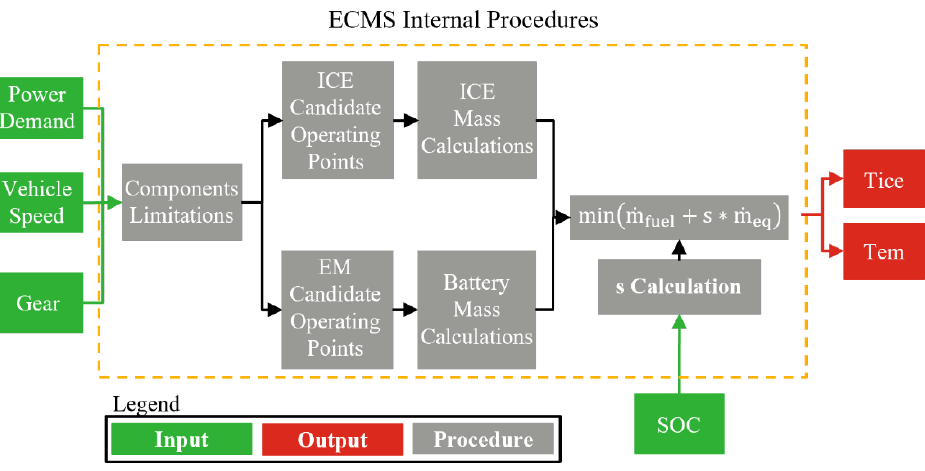
Figure 3. ECMS Procedure Overview